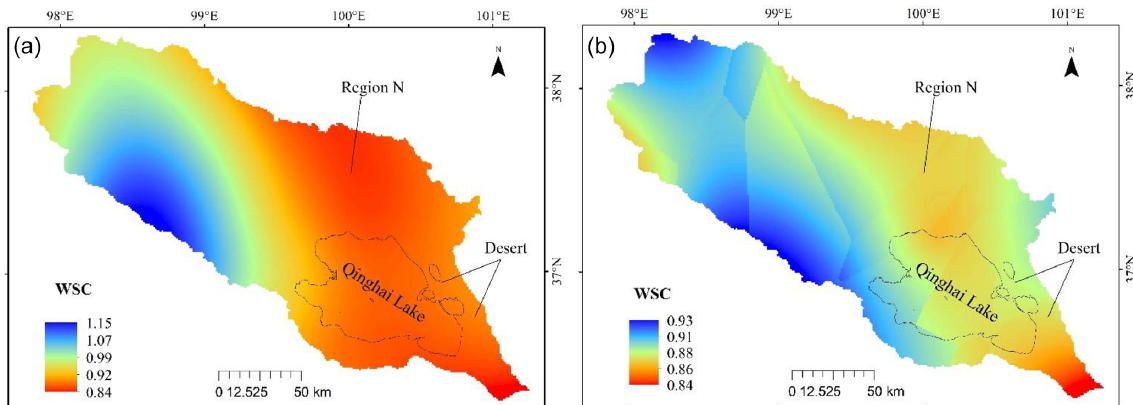
Figure 5. Comparison map of water stress coefficient (WSC) interpolation results in July 2020. (a) WSC from the spline method. (b) WSC from the kriging